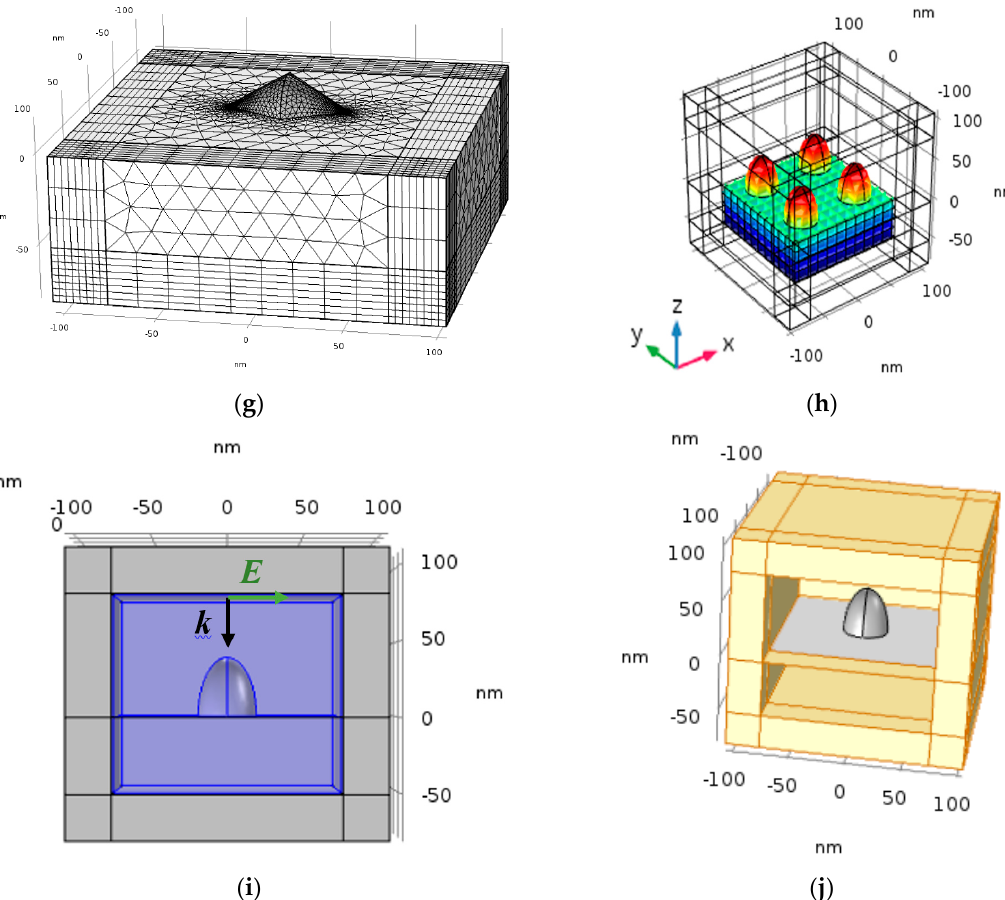
Figure 7. Tip structure different geometries: ( a ) hemi-sphere nano-particle; ( b ) hemi-spheroid nano-particle; ( c ) cavity; ( d ) nano-cone; ( e ) ellipsoidal rod; ( f ) ellipsoidal cavity; ( g ) double nano-cone; ( h ) SERS/TERS square; ( i ) the physical domain and the port input electric field excitation; ( j ) the PML domain.